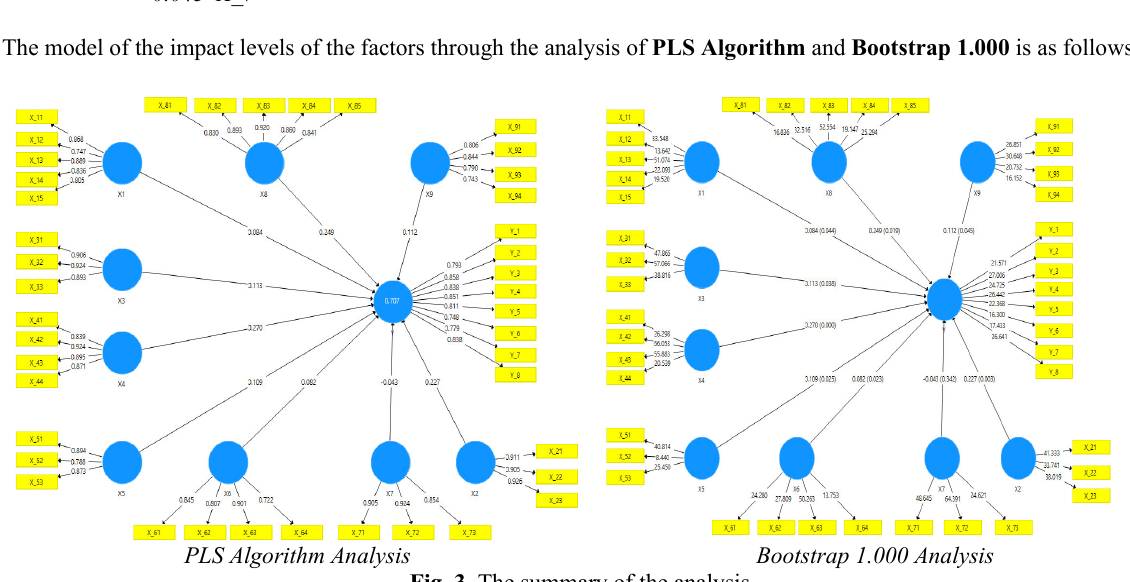
Fig. 3. The summary of the